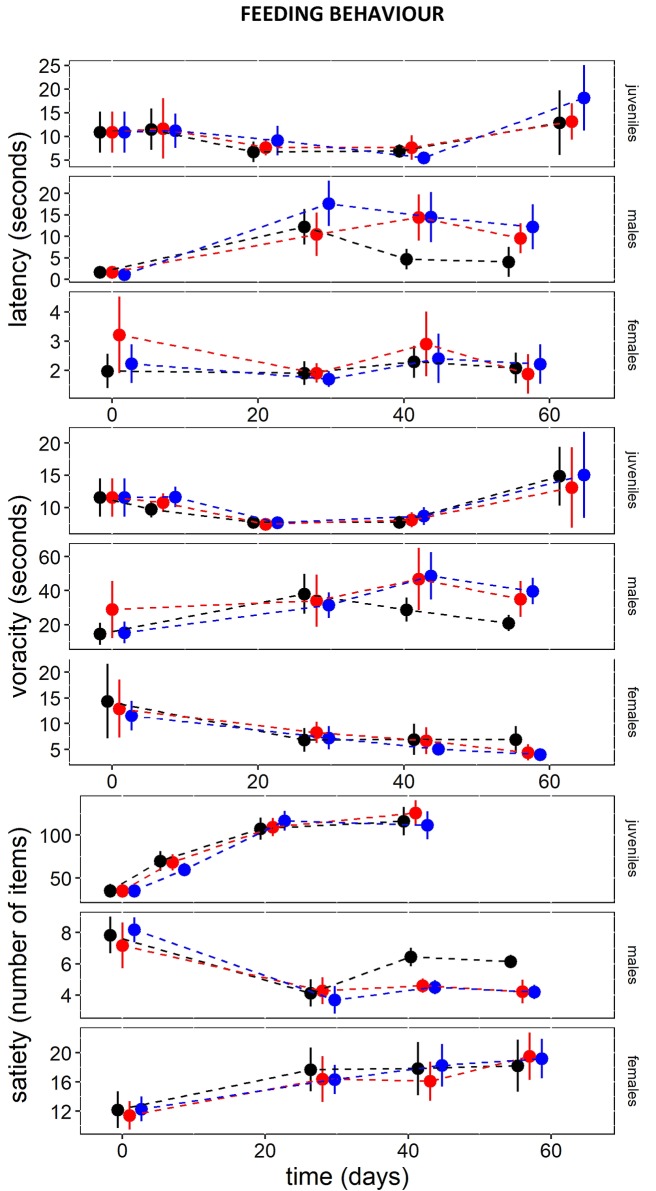
Feeding behaviour variables along the experiment.Symbols and bars represent means ± 95% confidence intervals for each variable and assigned for each treatment (black: control, red: 50 mg NO3-/l, blue: 250 mg NO3-/l). a) Latency is the time spent to capture the first food item. b) Voracity is the time to capture a given number of food items. c) Satiety is the total number of eaten food items.